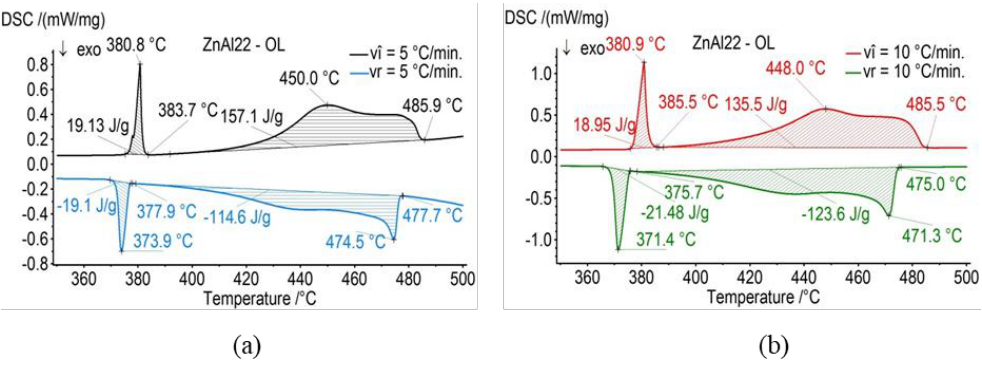
Figure 7. DSC curves for the ZnAl22 alloy cast with steel die with: ( a ) vî = vr = 5 °C/min and ( b ) vî = vr = 10 °C/min.